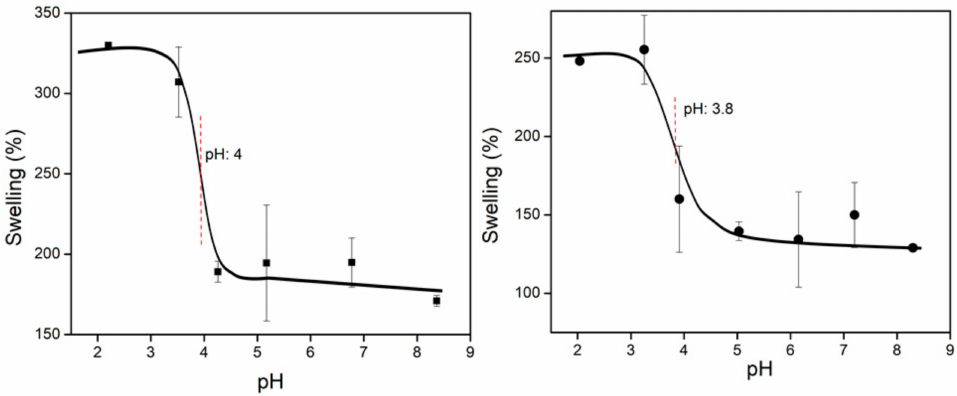
Figure 10. Critical pH at room temperature of net -CS ( (cid:4) ) ( left ), and ( net -CS)- g -NVCL/AAc (32% graft) ( • ) ( right